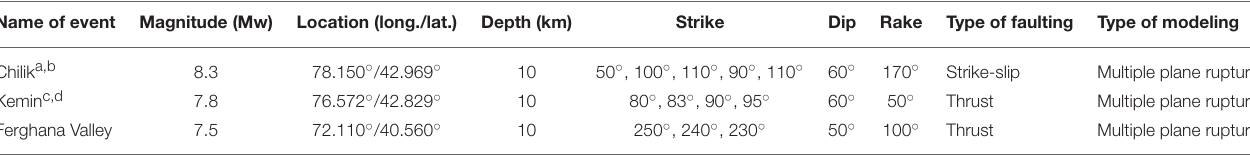
TABLE 1 | The historical (Chilik, Kemin) and expected (Ferghana Valley) events considered in this work and modeled using the OpenQuake suite of software tools (Pagani et al., 2014 , Silva et al.,